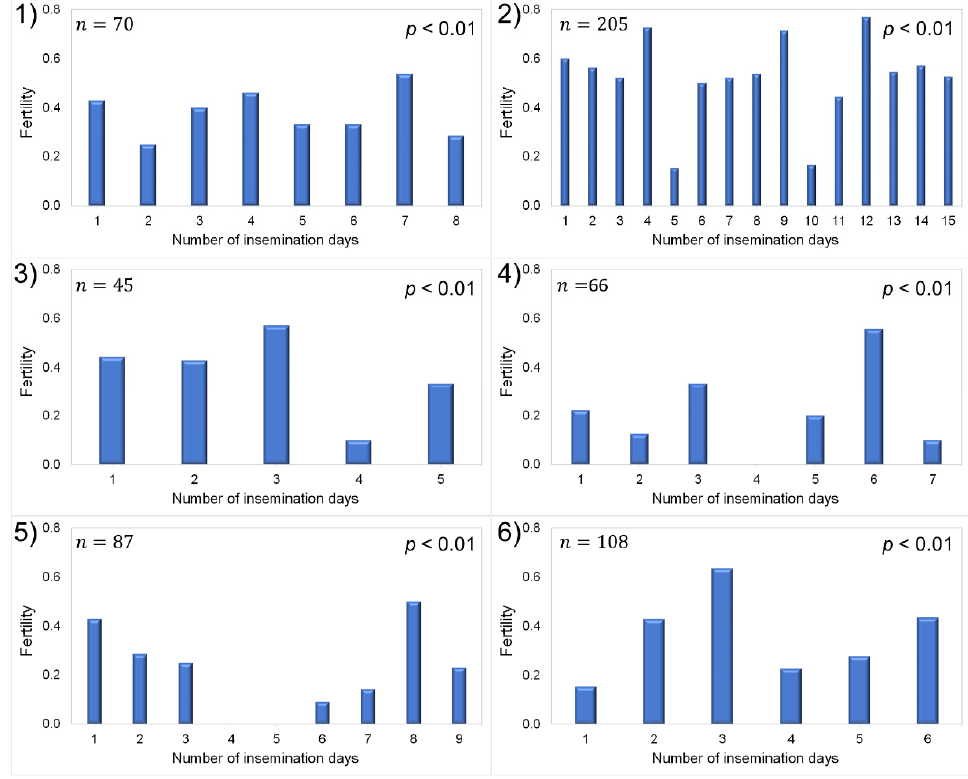
0.40, 45.16% had fertilities between 0.40 and 0.80, and 4.8% of the rams had fertilities > 80%. Male fertility is influenced by a multitude of intrinsic factors such as animal age and semen factors characteristics [21,32]; however, the factors related to ewes are as much or more important to fertility. The origin of the animals, the weather season in which they are inseminated [33], the protein nutritional inputs received by the ewes during the in- semination process [34], and even weather conditions on the day of insemination [35] are other external factors that influence fertility. All of those factors, together with the small number of ewes inseminated per ram, explain the extreme variations in fertility per ram and insemination day. Figure 1. Fertility results of organic Churra ewes in Spain in six years of insemination (1–6) for each of the insemination days; n : number of ewes inseminated. Fertility values range between 0 and 1. The number of ewes inseminated by the AI protocol developed in our study per ram was very small because it depended on the number of ewes marked on that day and on the availability of semen from the individual ram (Figure 2). The number of ewes insemi- nated per ram ranged from 1 to 26. This, together with the inherent variability of the rams, meant that the resulting fertility differed significantly ( p < 0.01) among rams. About a quarter (24.19%) of the rams had fertilities < 0.20, 25.80% had fertilities between 0.20 and